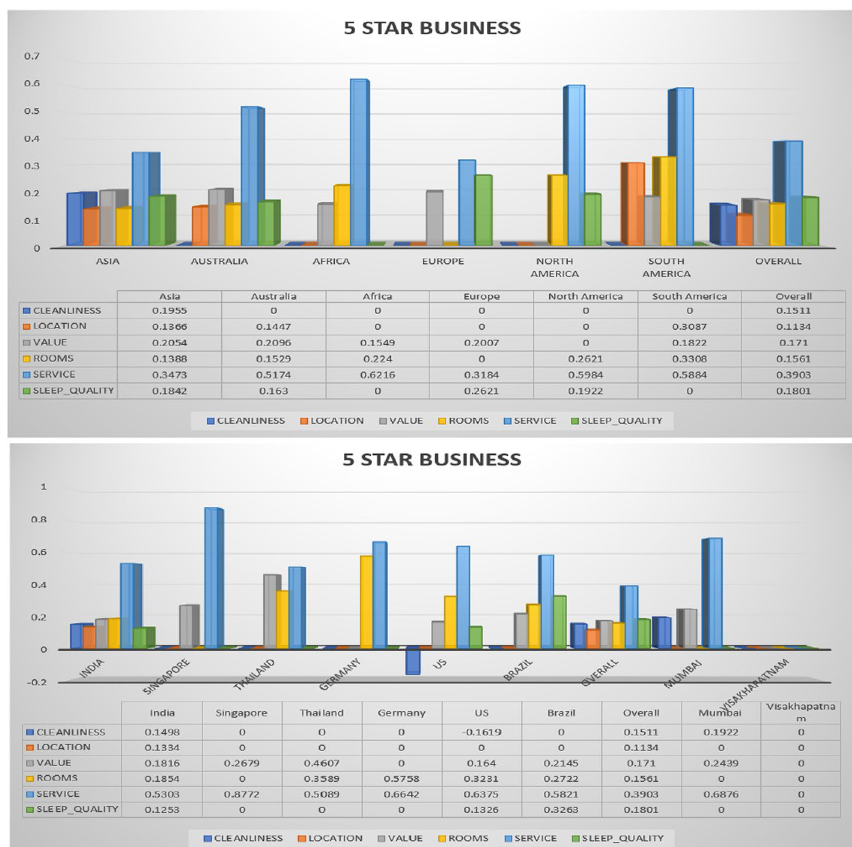
Fig. 3 Hotel class: 5 star, Trip Type: Travelled on business (continent, country and